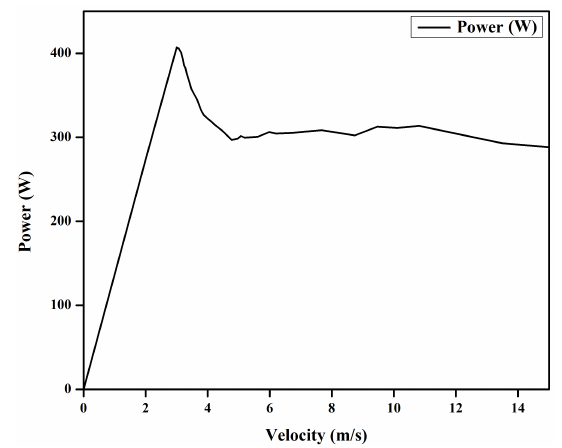
Figure 16. Output power at different